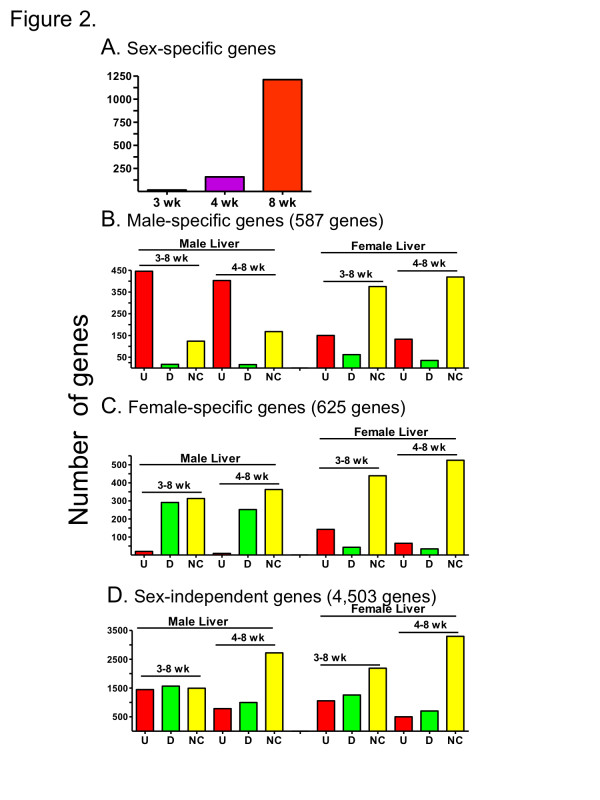
Numbers of sex-specific genes and patterns of developmental regulation of adult sex-specific genes and adult sex-independent genes. Bar graphs present the number of genes that are either sex-specific in adult mouse liver or are up regulated (U), down regulated (D), or not significantly changed in expression (NC) from 3 wk to 8 wk or from 4 wk to 8 wk in male and female liver, as marked. A. The number of adult sex-specific genes increases from 3 to 8 wk, with onset of sex-specificity primarily occurring between 4 wk and 8 wk. B. Adult male-specific genes are predominantly up regulated in male liver, while in female liver they are mostly not regulated. C. Adult female-specific genes are primarily down regulated or are not regulated in male liver, while in female liver they are mostly not regulated. D. A somewhat greater number of adult sex-independent genes are regulated from 3 or 4 wk to 8 wk in male liver compared to female liver.